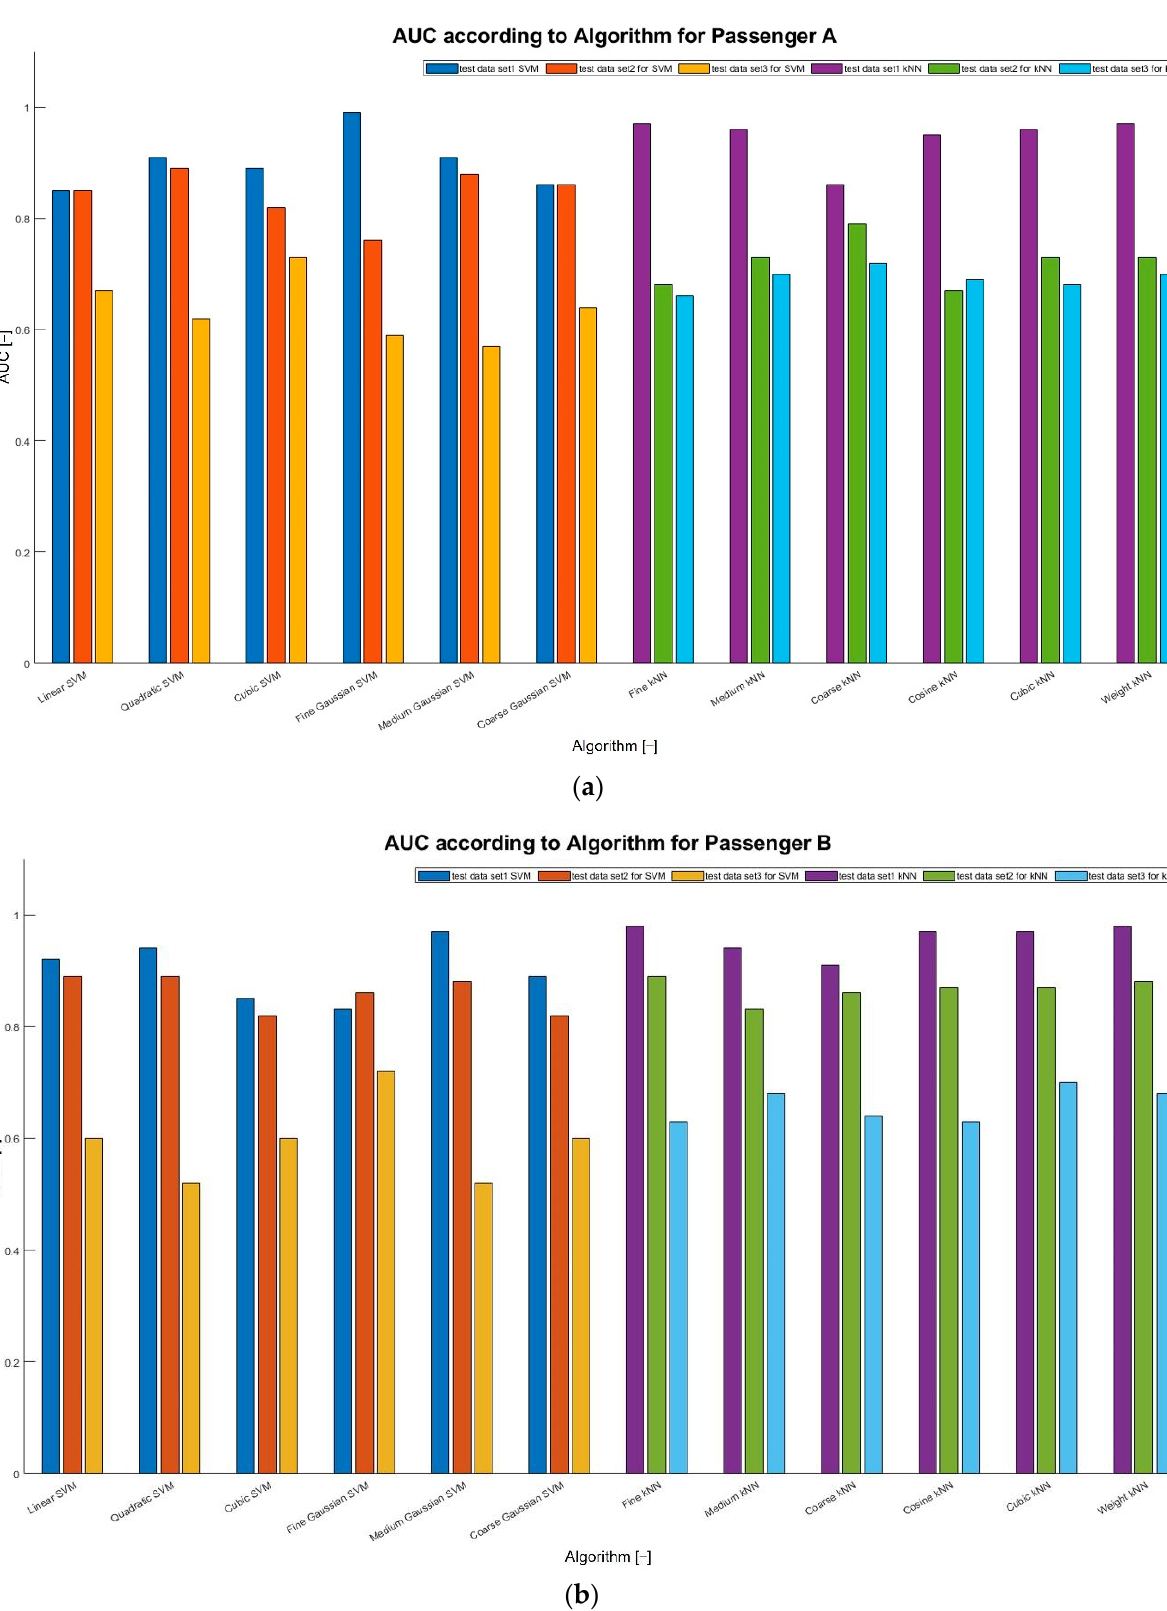
Figure 7. Test accuracy of all the passengers: ( a ) test accuracy of passenger A; ( b ) test accuracy of passenger B; and ( c ) test accuracy of passenger C.